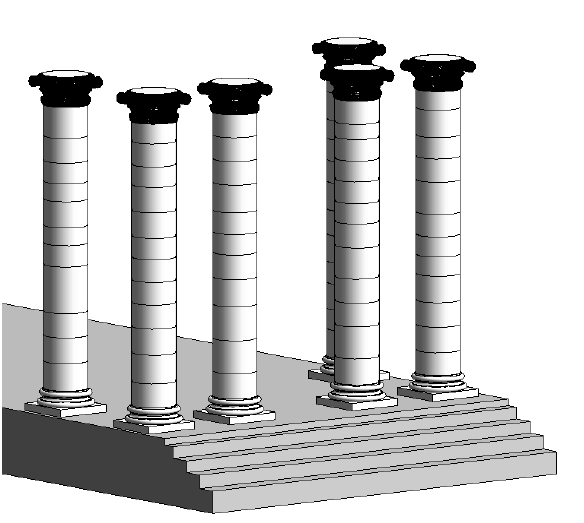
Figure 13. 3D model of the colonnade from the aggregation of the different modeling processes (parametric, algorithmic and polygonal modeling) identified with reference to the parts of